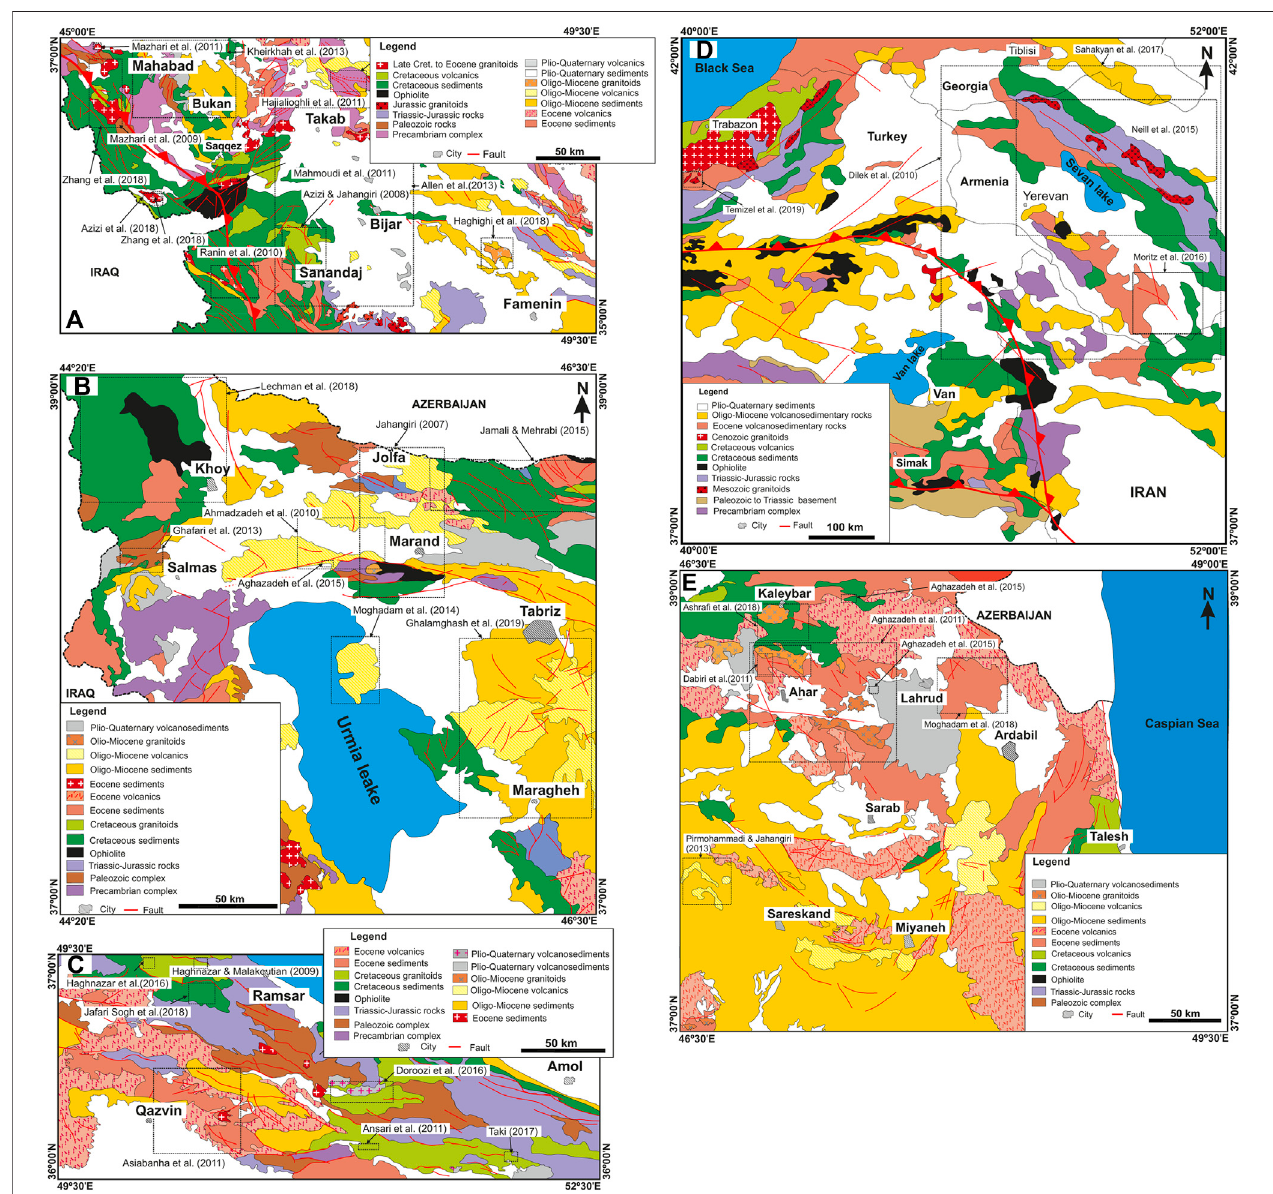
FIGURE4|(A – E) DetailedgeologicalmapsofthemainmagmaticunitsandmajorfaultsdistributedbetweentheBlackandCaspianSeas.Thelocationofcollected data and references are shown in the maps. For the location of each map, see Figure 3